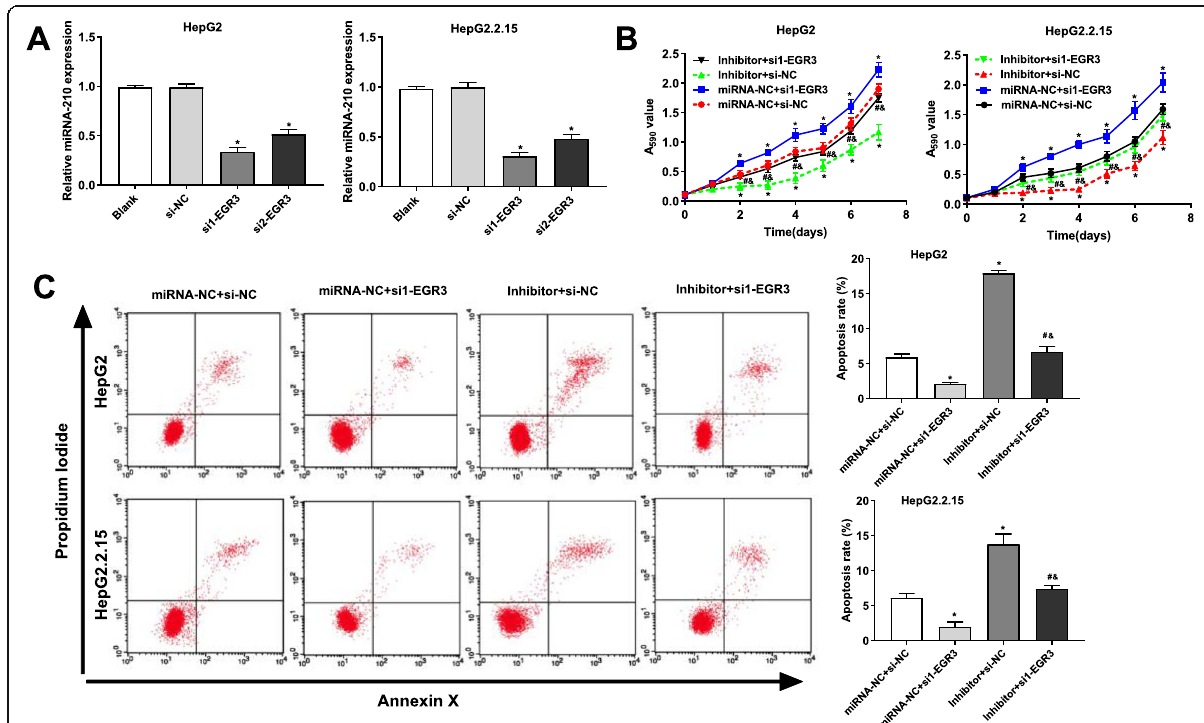
Fig. 7 Silencing of EGR3 reversed the effect of miRNA-210 inhibitor on HepG2 and HepG2.2.15 cells. a The expression of miRNA-210 was significantly decreased by the transfection of si1- or si2-EGR3. * P < 0.05 compared with the Blank group. b Silencing of EGR3 reversed the inhibiting effect of miRNA-210 inhibitor on the viability of HepG2 and HepG2.2.15 cells. c Silencing of EGR3 reversed the promoting effect of miRNA-210 inhibitor on the apoptosis of HepG2 and HepG2.2.15 cells. * P < 0.05 compared with the miRNA + si-NC group. # P < 0.05 compared with miRNA-NC + si1-EGR3. & P < 0.05 compared with inhibitor + si1-NC. All experiments were performed in triplicate, and data were expressed as mean ± standard deviation